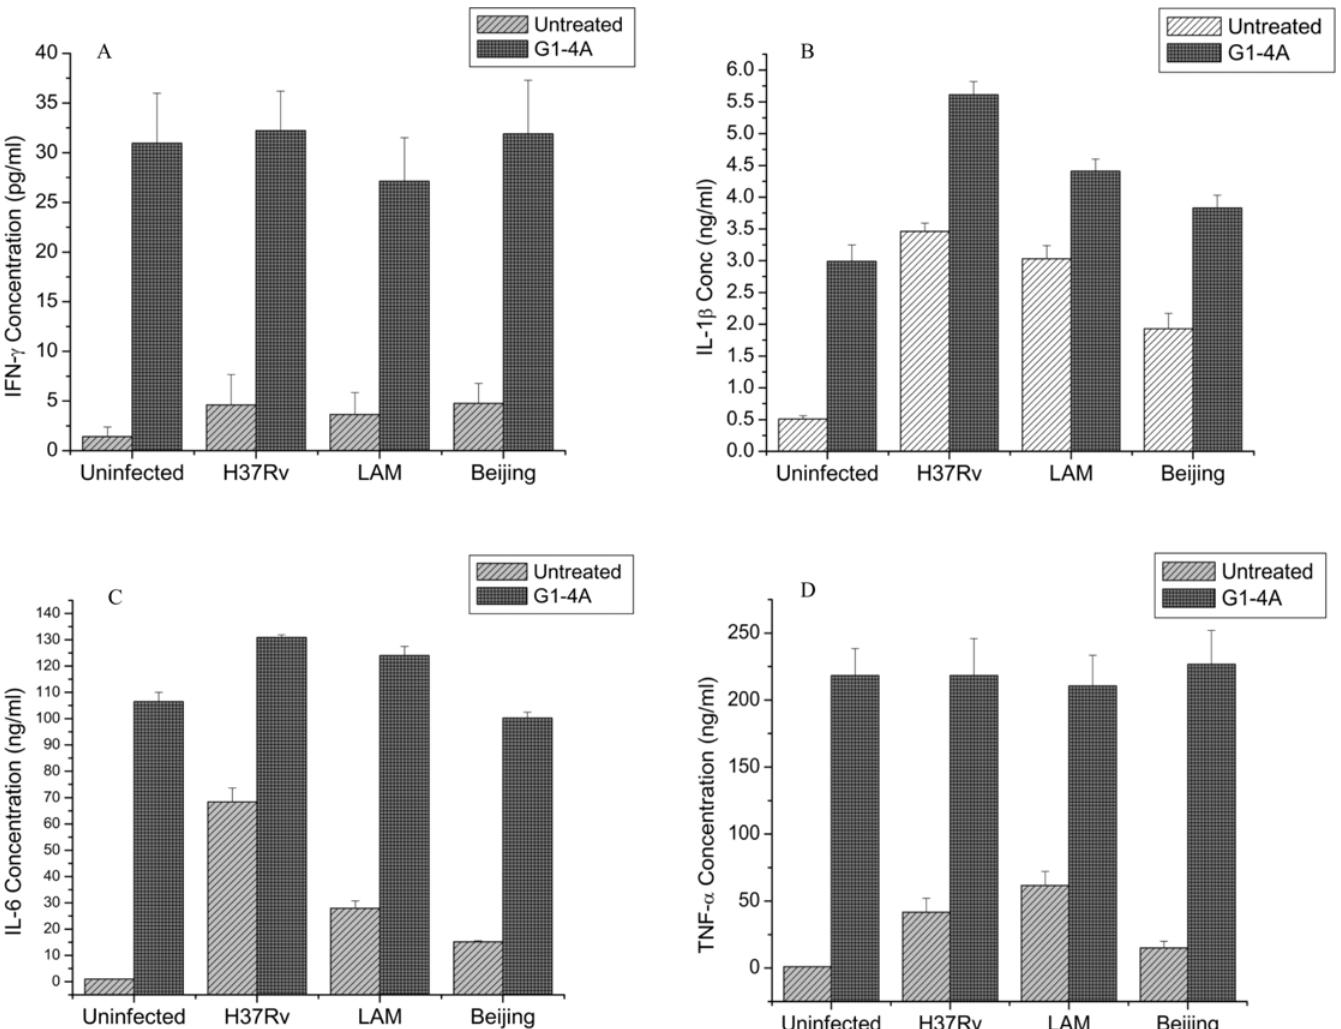
Fig 1. G1-4A mediated cytokine production by MTB infected RAW cells. RAW cells were treated with G1-4A (1 mg/ml), for 8 h and infected with three strains of MTB i.e. H37Rv, LAM and Beijing at MOI 5. Four hours after infection cells were retreated with G1-4A for 24 h. Cytokines levels were quantified in supernatants by ELISA, (A)- IFN- γ , (B)-IL-1 β , (C)-IL-6, (D)-TNF- α . Results shown here are from a single representative experiment out of at least three independent experiments performed and presented as mean ±